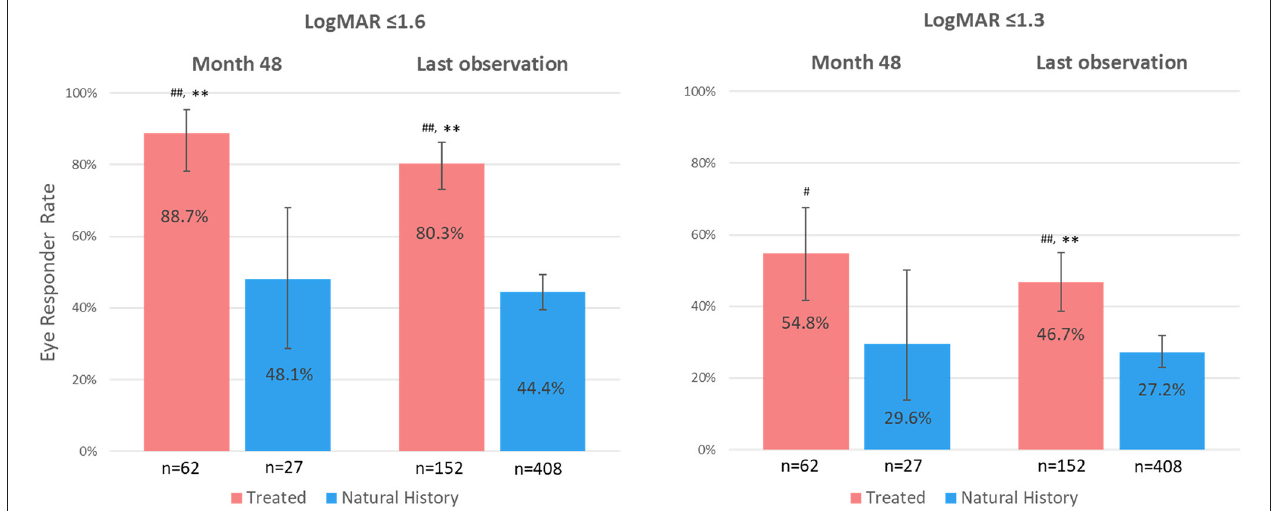
FIGURE 2 | Eye responder rates at month 48 since vision loss and at last observation. LogMAR, logarithm of the minimal angle of resolution; n, number of eyes. Response rates (%) are defined as the proportion of eyes with visual acuity values ≤ 1.6 LogMAR (left panel) or ≤ 1.3 LogMAR (right panel). Error bars represent 95% confidence interval. # P < 0.05, ## P < 0.01: statistically significant difference vs. natural history eyes using chi-square test. ** P < 0.01: statistically significant difference vs. natural history eyes using a generalized linear mixed model with repeated measures on a